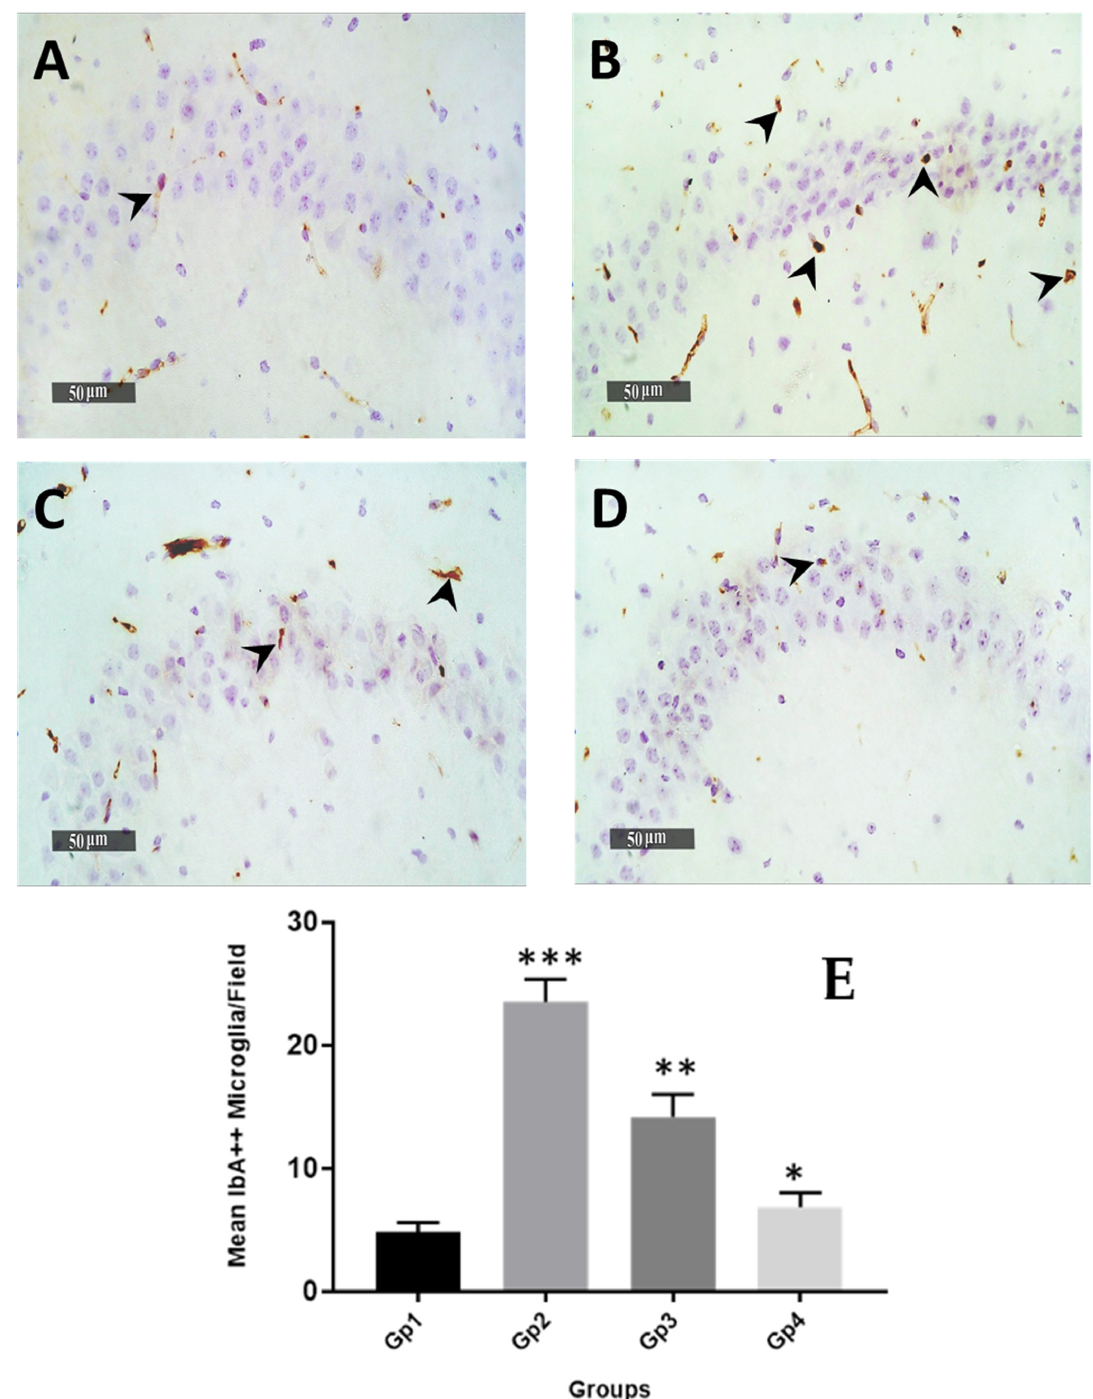
Figure 10. Effect of different treatments on hippocampal IbA/++ activated microglial cells count expressed as the mean number of IbA/++ cells per microscopic field. ( A ) Normal group, ( B ) Negative control group, ( C ) Positive control group and ( D ) Test group. 400 × . The bar chart ( E ) shows the mean ± SD of the % area of immuno-histochemical levels expression of GFAP, where Gp 1 represents the normal group, Gp 2, Gp 3 and Gp 4 represent the negative control group (received 0.9% saline), positive control group (received resveratrol suspension) and test group (received resveratrol bilosomes), respectively, where (*), (**) and (***) indicate statistically significantly different values from the control group at ( p < 0.05, p < 0.01 and p < 0.001), respectively .